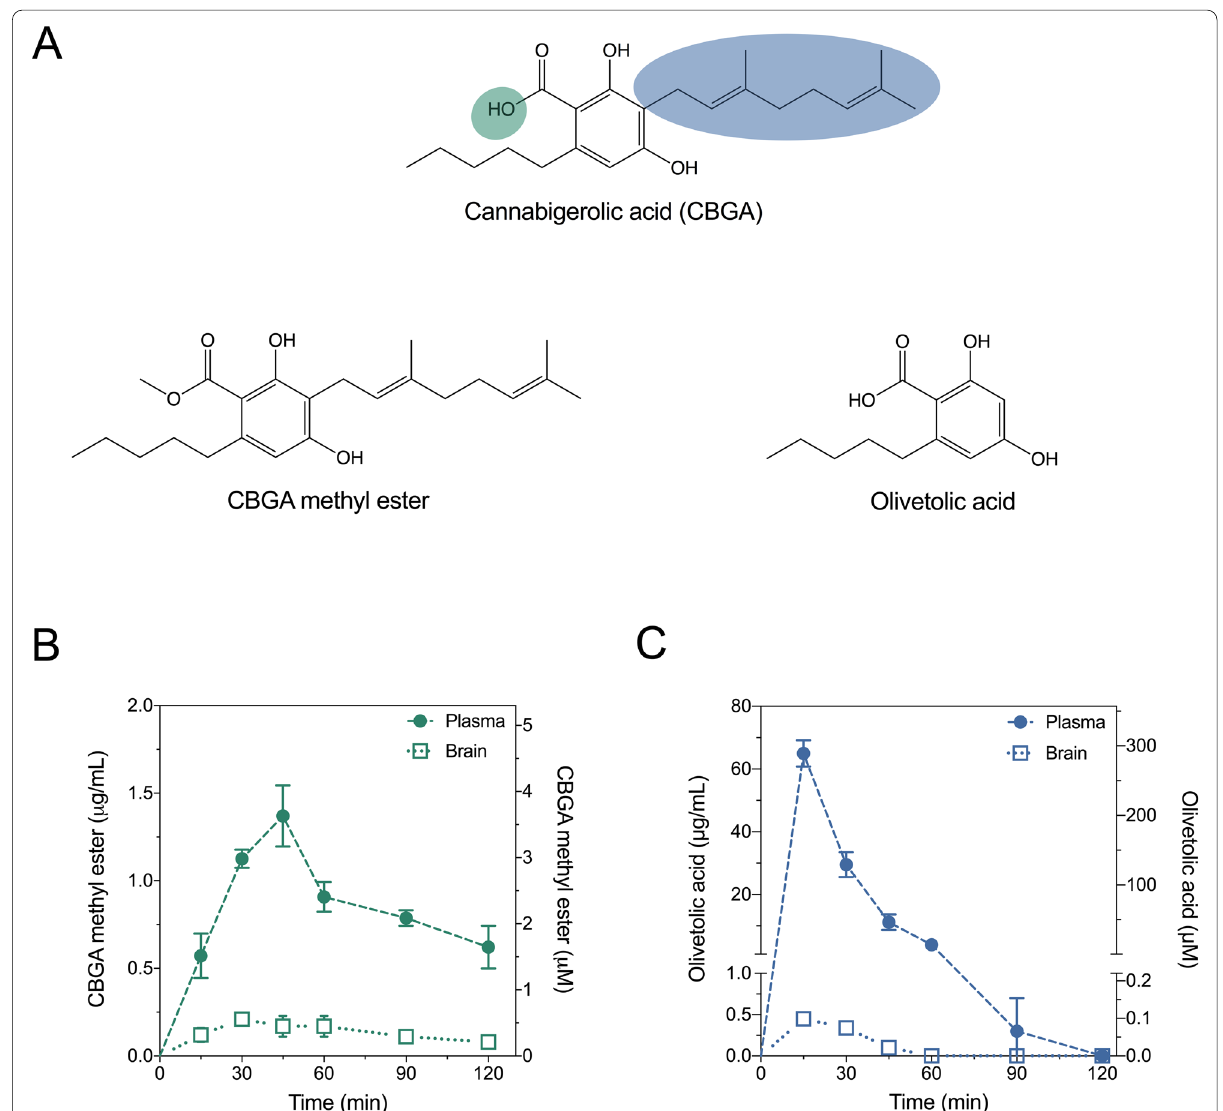
Fig. 1 Pharmacokinetic analysis of CBGA methyl ester and olivetolic acid in the mouse plasma and brain samples. A Comparison of the chemical structure of cannabigerolic acid (CBGA) to those of CBGA methyl ester and olivetolic acid. Concentration‑time curves for B CBGA methyl ester in the plasma and brain and C olivetolic acid in the plasma and brain following 10 mg/kg i.p. injections. Concentrations are depicted as both mass concentrations (left y ‑axis) and molar concentrations (right y ‑axis). Data are expressed as means